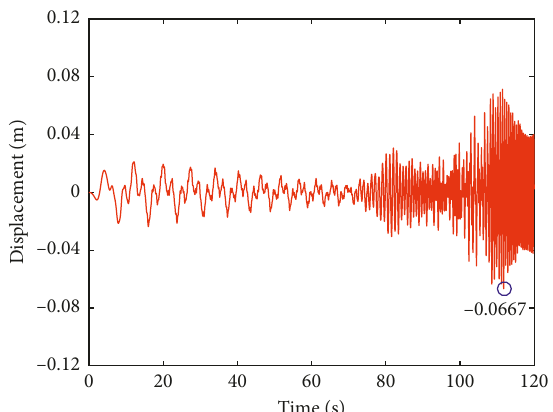
Figure 8: Total lateral vibration displacements at l enary rope in lowering.